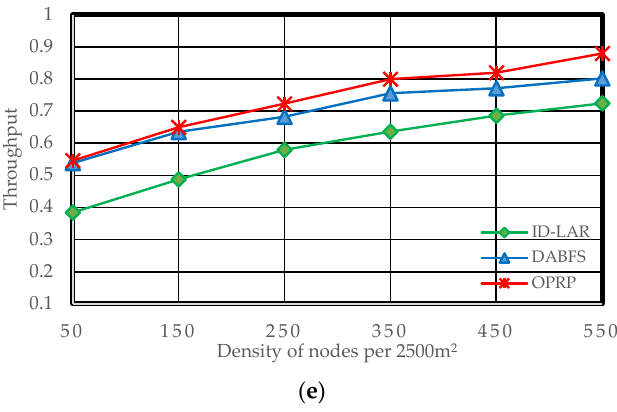
Figure 7. Throughput during the dissemination of WM. ( a ) Scenario 1: H (S, D) = 1, S is rear, and D is front. ( b ) Scenario 2: H (S, D) = 1, S is front, and D is rear. ( c ) Scenario 3: H (S, D) = 0, S and D are moving toward each other. ( d ) Scenario 4: H (S, D) = 0, S and D are moving away from each other. ( e ) Scenario 5: H (S, D) = 0, S and D are moving toward each other in opposite directions.